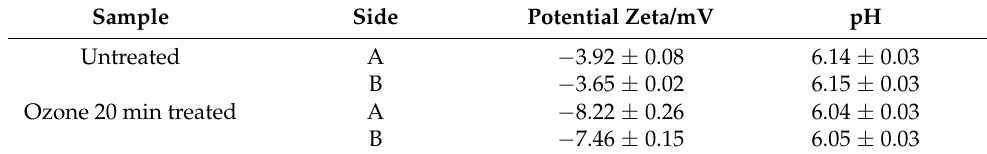
Table 1. Results of Zeta potential of polyester samples before and after 20 min of ozone treatment.